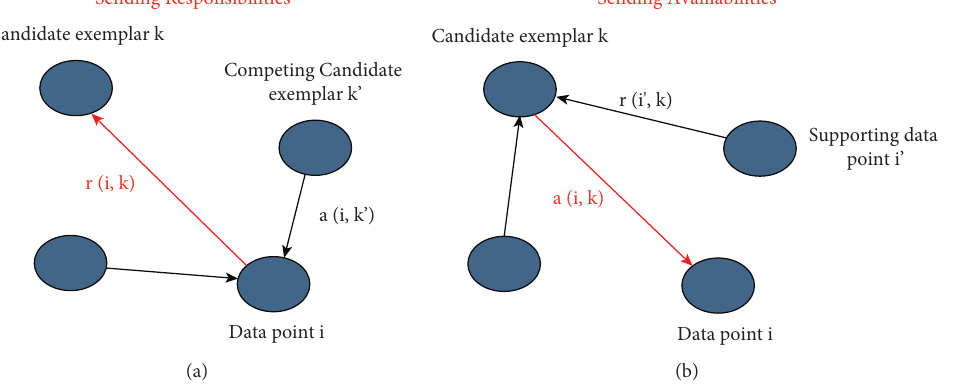
Figure 1: Message-exchange process of affinity propagation [32].